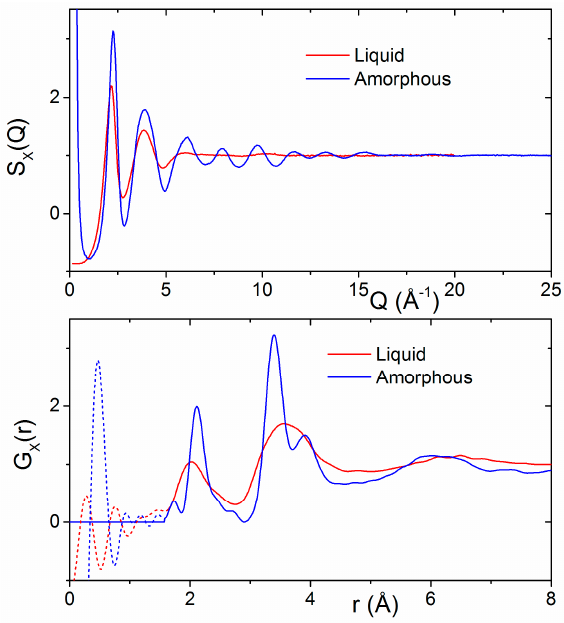
Figure 5. ( Top ) Comparison of the X-ray structure factors for liquid HfO 2 and amorphous hafnia nanoparticles. ( Bottom ) A comparison of the corresponding X-ray pair distribution functions G X (r).